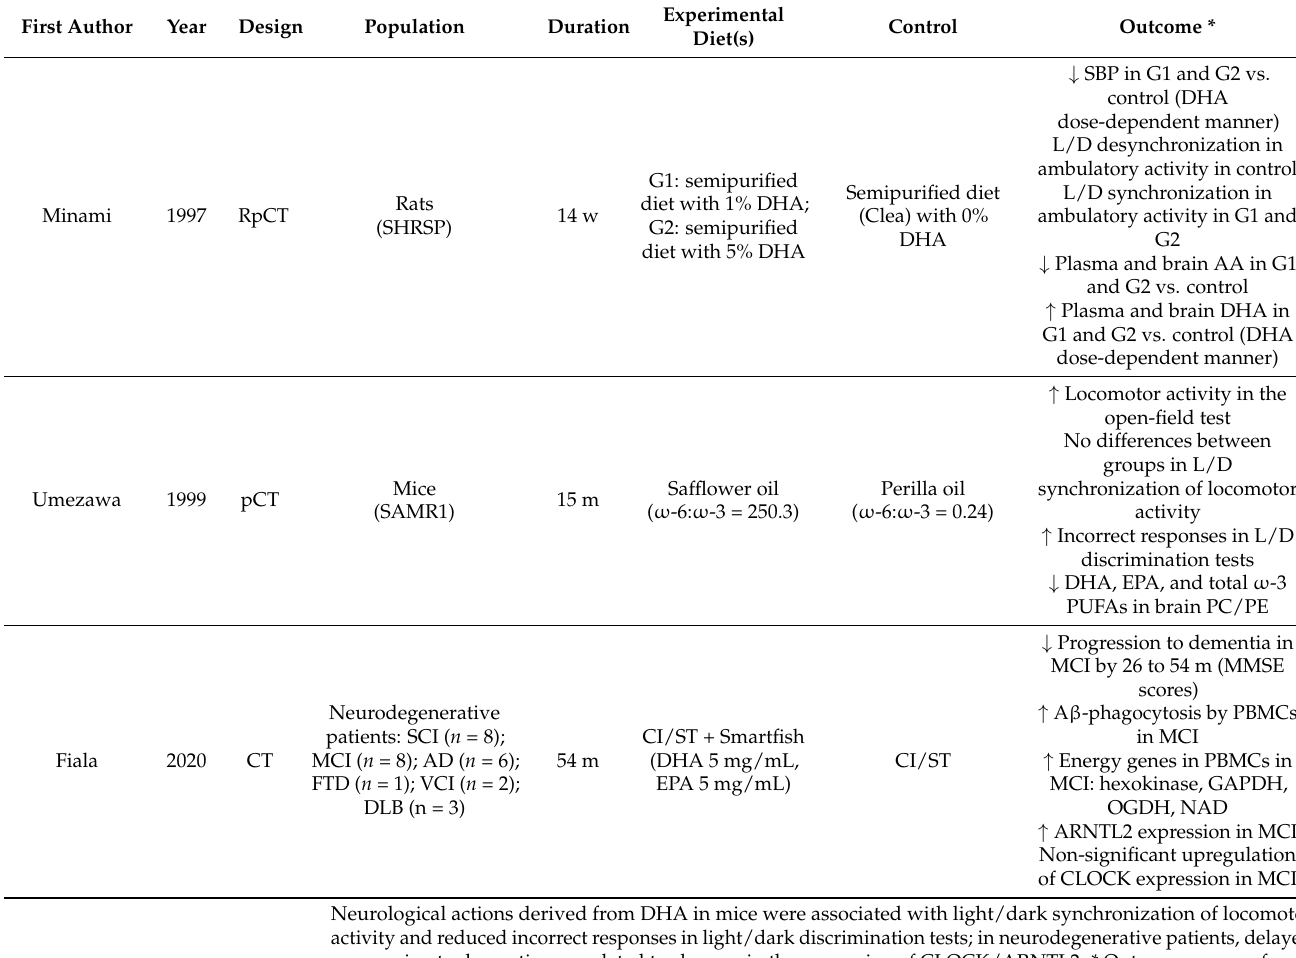
Table 3. Selected studies on the regulation of neurological functions by omega-3 fatty acids via clock